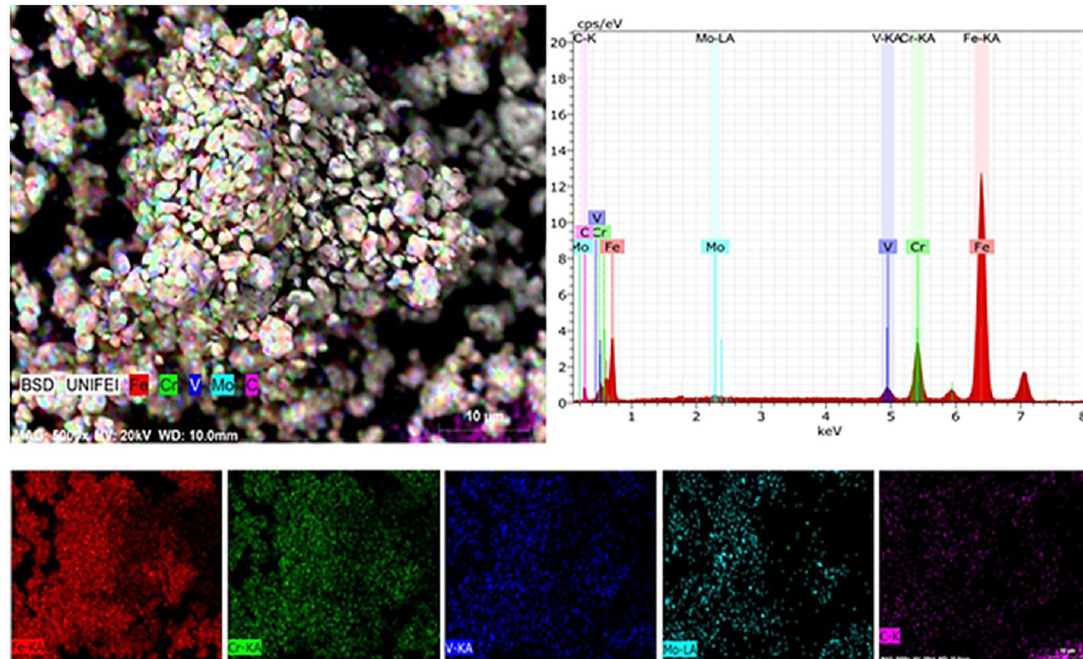
Figure 2. Semi-quantitative chemical analysis and mapping of X22CrMoV12-1 alloy with addition of VC particles after 60 hours of milling.